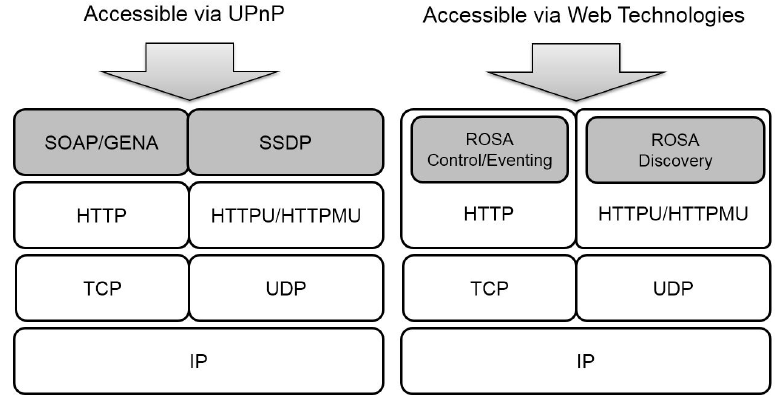
Figure 3. A comparison of protocol stacks between UPnP and